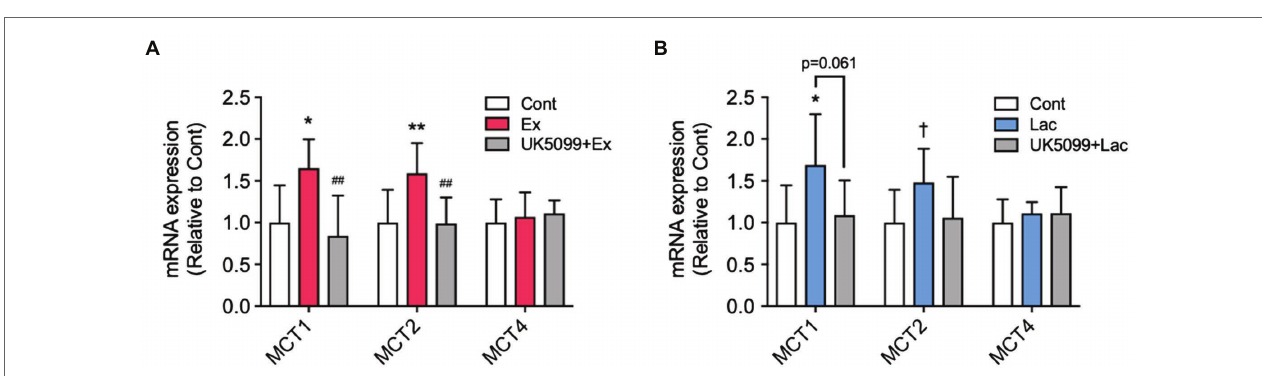
FIGURE 4 | The effects of UK5099 on the hippocampal MCTs and BDNF mRNA expression after lactate administration and high-intensity exercise. Mice were injected with saline or UK5099 by I.P. injection 30 min before a single bout of high-intensity exercise and lactate administration. MCT1, MCT2, and MCT4 mRNA expression in the hippocampus 12 h after (A) exercise (Cont, n = 10; Ex, n = 9; UK5099 + Ex, n = 9) and (B) I.P. injection of lactate (Cont, n = 9; Lac, n = 9; UK5099 + Lac, n = 8). All data were presented as the mean ± SD values. Data were analyzed using one-way ANOVA with Tukey’s post-hoc tests. * p < 0.05; ** p < 0.01; and † p < 0.1 in comparison with Cont group and ## p < 0.01 in comparison with Ex group.